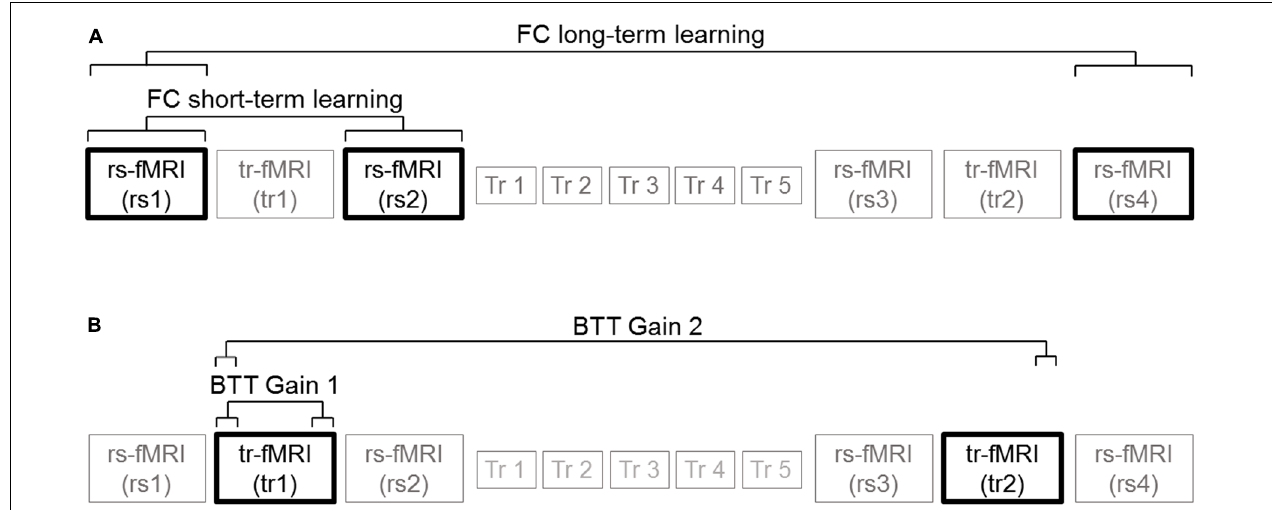
FIGURE 3 | Brain-behavior correlations. (A) Functional connectivity measures: Connectivity changes extracted from rs2 minus rs1 (FC short-term learning), and also from rs4 minus rs1 (FC long-term learning) for inter- (homotopic, heterotopic) and intra-hemispheric (right, left) connectivity measures. (B) BTT gain measures: Last 15 trials of tr1 minus first 15 trials of tr1 (BTT Gain 1), and also last 15 trials of tr2 minus first 15 trials of tr1 (BTT Gain 2) for N-ISO conditions.